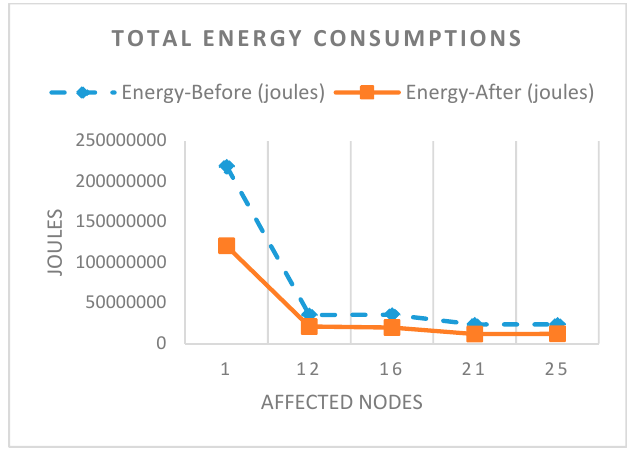
Figure 11. Energy consumed by nodes before and during rainfall.